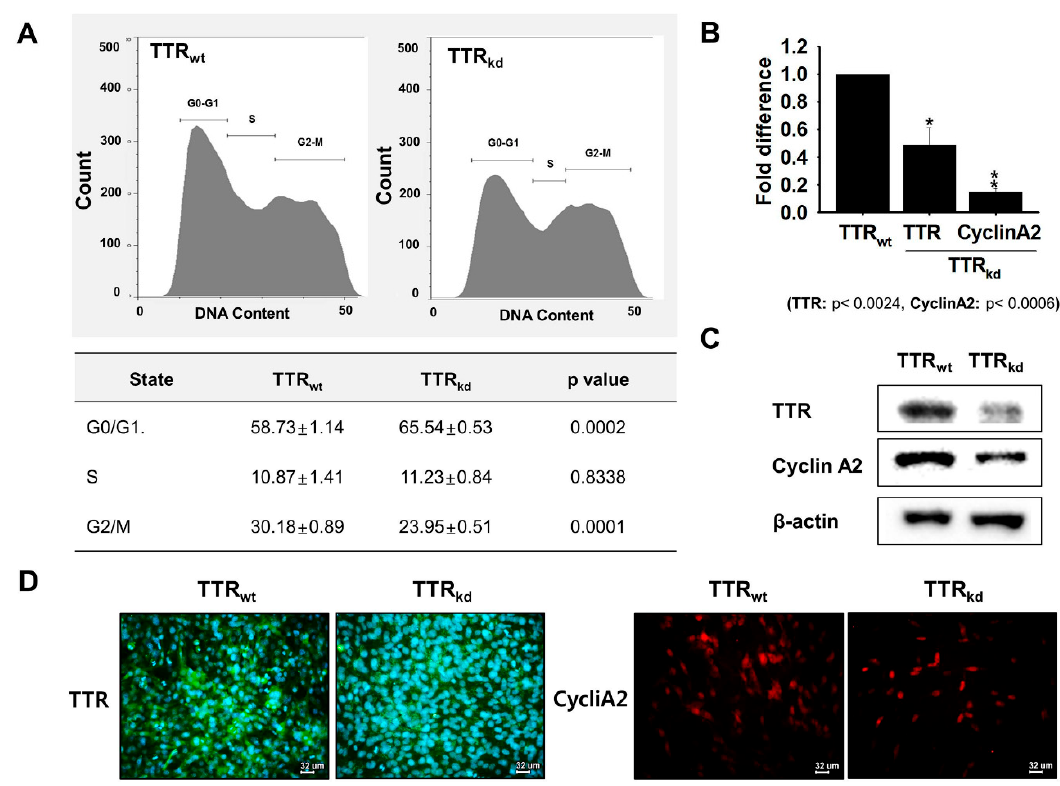
Figure 3. TTR expression during cell proliferation. TTR and CyclinA2 expressions during cell cycle progression of C2C12 cells: ( A ) difference in growth patterns of TTR wt and TTR kd cells as determined by FACS; ( B , C ) TTR and CyclinA2 expression in TTR wt and TTR kd cells by RT-PCR or Western blot; and ( D ) confirmation of expressional differences of TTR or CyclinA2 by immunocytochemistry (green: TTR; red: CyclinA2; Blue: Nucleus). p -values indicate statistical significance (mean ± S.D., n = 3, *: p < 0.05, **: p < 0.001).